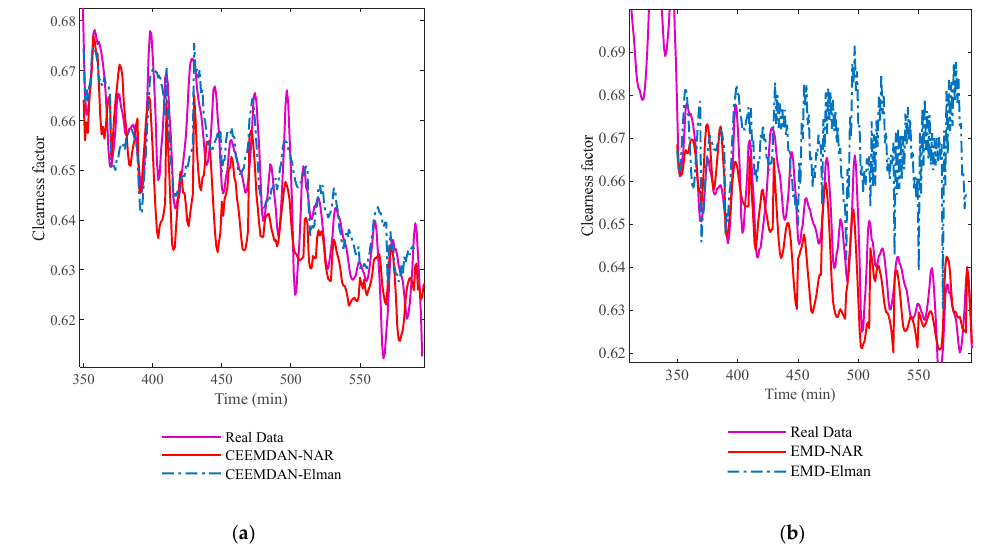
Figure 8. Five-step-ahead prediction of M5, M6 without any decomposition algorithm ( a ) and partial enlarged figure ( b ).